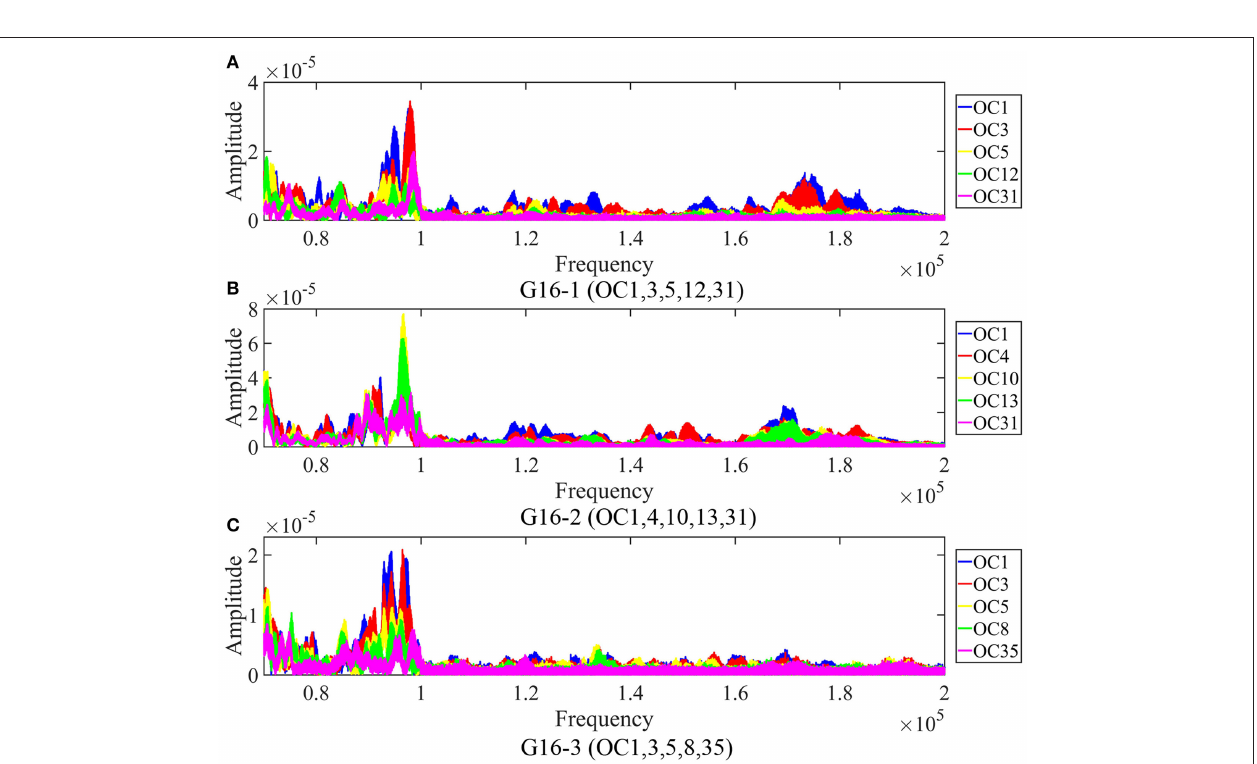
FIGURE 8 | Frequency-domain signal of G16 after testing under different operating conditions. (A) Frequency domain of G16-1 under different operating conditions. (B) Frequency domain of G16-2 under different operating conditions. (C) Frequency domain of G16-3 under different operating conditions.